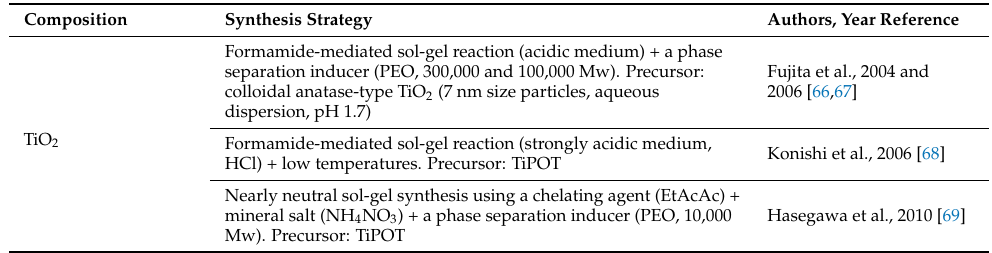
Table 3. Specific examples of synthesis strategies for the achievement of non-siliceous single oxide porous monoliths, prepared via sol-gel/phase separation